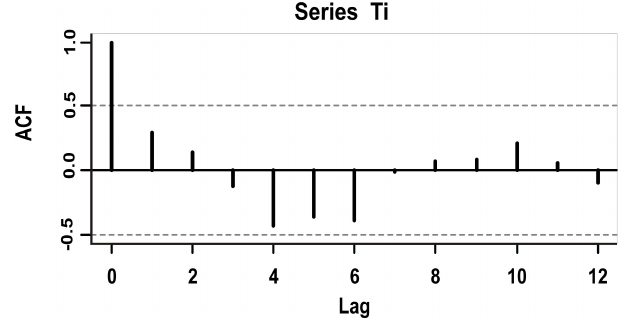
Fig. 3. Autocorrelation function for the repose intervals of the Ca- nary Islands’ time